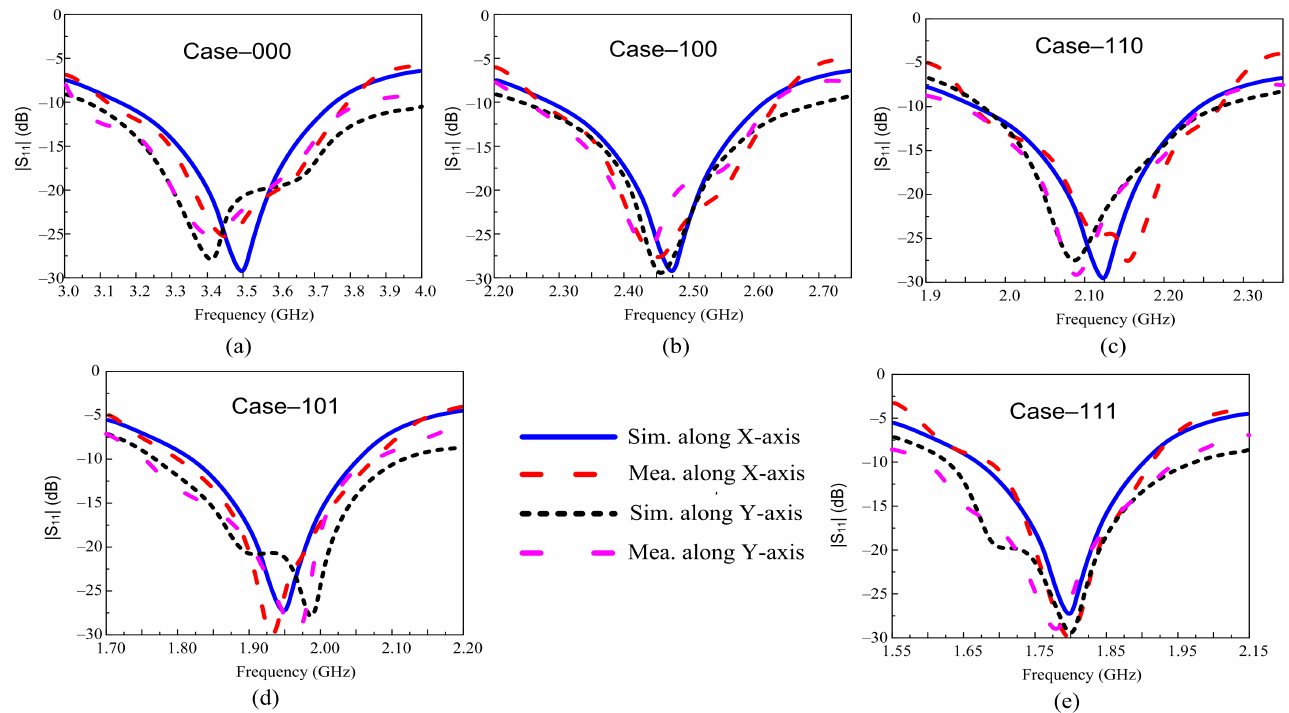
Figure 11. Simulated and measured |S 11 | of the proposed antenna under conformal conditions.